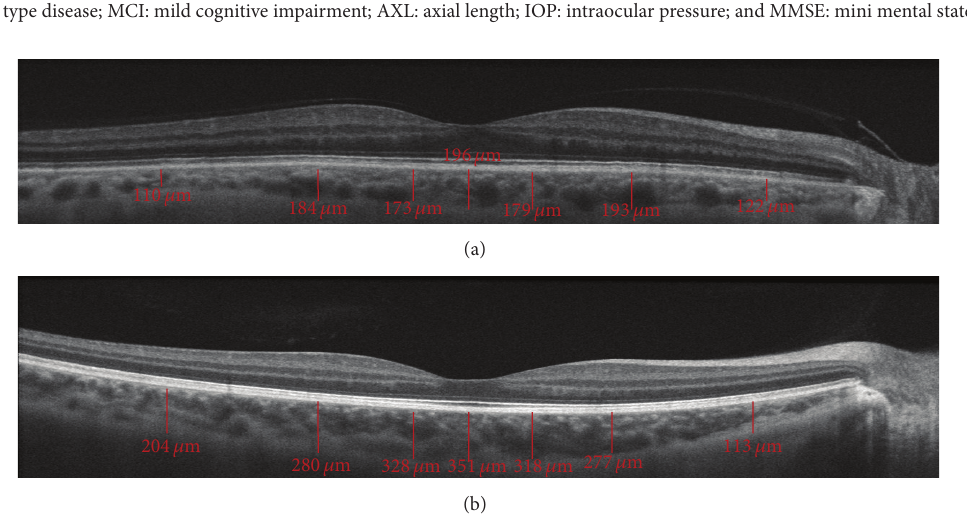
Figure 2: This figure shows that choroidal thickness measurement at each location in both a healthy individual (b) and a patient with ATD (a).